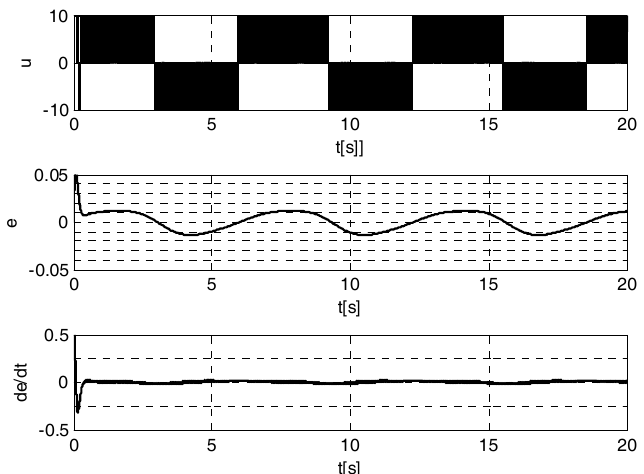
Figure A8. Time histories of u , e , e with the proportional-derivative (PD) controller (A3) and a PWM modulator with sampling time T = 0.01.